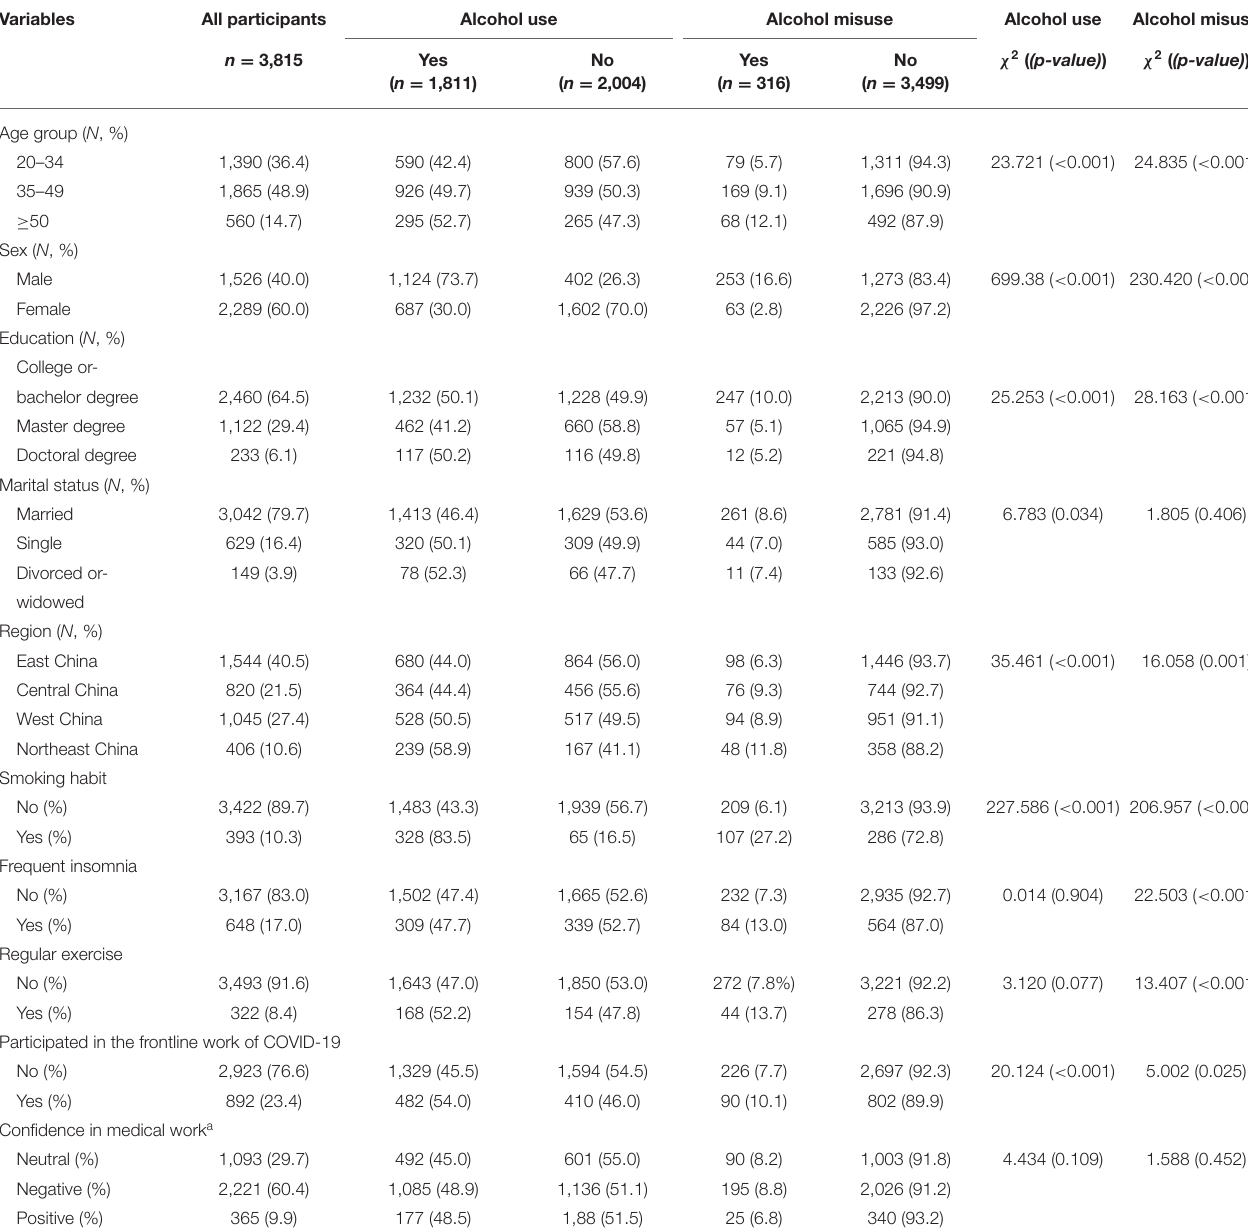
TABLE 1 | Basic features of 3,815 psychiatrists, and subgroup comparisons between those endorsed alcohol use, alcohol misuse and those who did